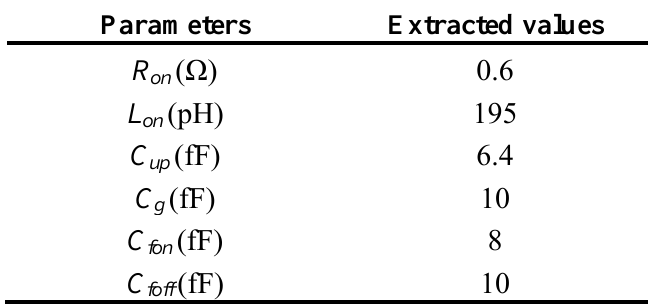
Table 2. Extracted parameters of the 3-port MEMS